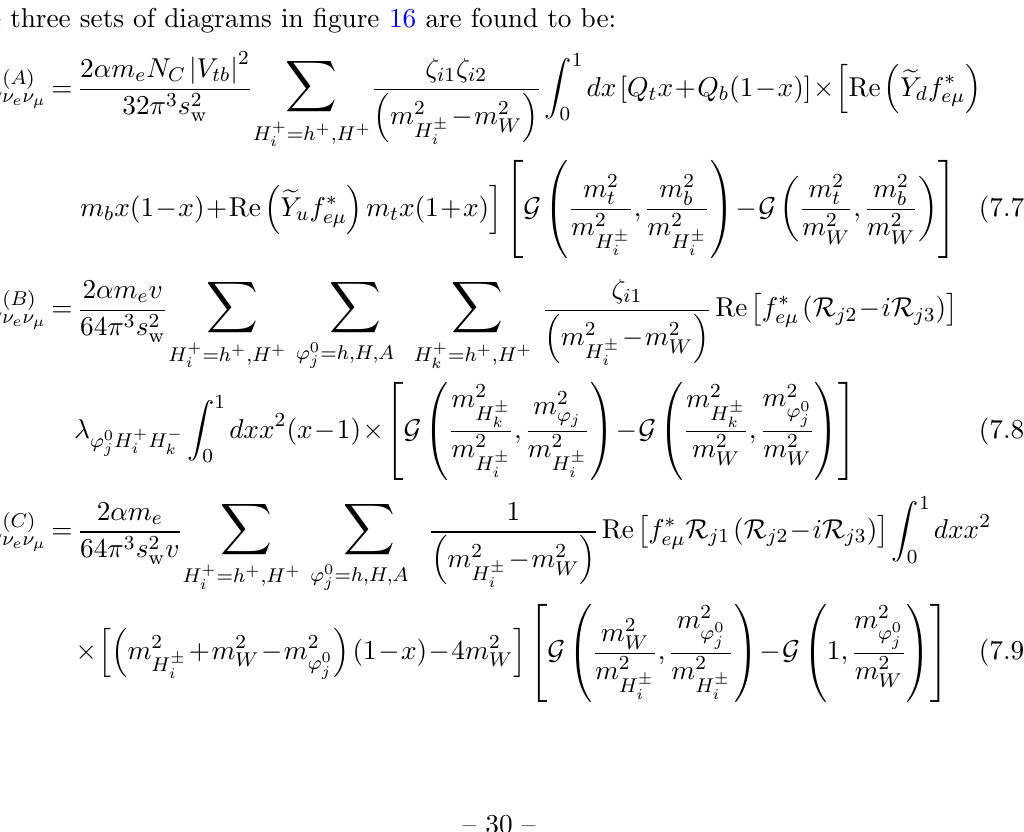
H (cid:0) (cid:13) vertex: k k